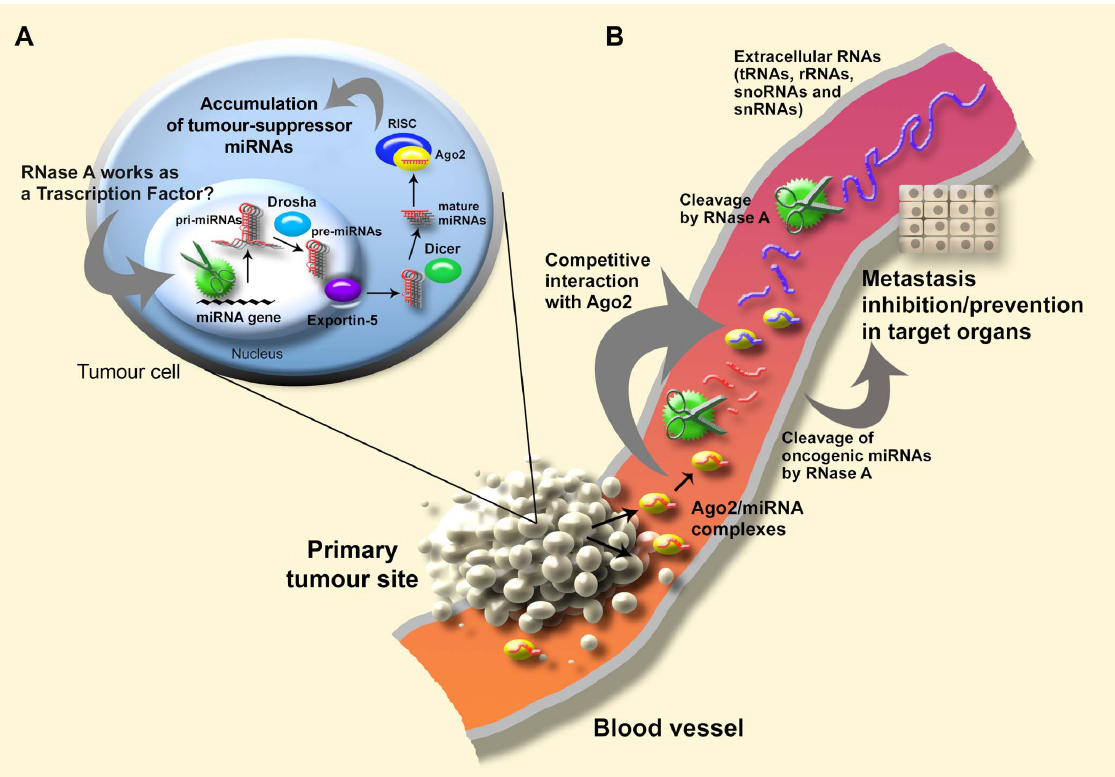
Figure 6. Hypothetical mechanism of the effects of RNase A on the biogenesis of tumour-derived and circulating miRNAs. A . In tumour cells, positively charged RNase A binds with negatively charged tumour tissue (due to the presence of anion phosphatidylserine residues on the surface of tumour blood vessels) and penetrate into the cells. RNase A-mediated increase in miRNA levels in tumour cells may be a result of the activity of RNase A or its proteolytic fragment as a transcription activator. Apparently RNase A displays some properties of homologous angiogenin, which was shown to stimulate ribosomal RNA transcription and protein synthesis [46] and thus can possibly act as a transcriptional activator in tumour cells. B . The primary tumour site is a source of extracellular nucleoprotein complexes, in particular miRNA/Ago2 complexes [37,38]. Recent studies have shown a large number of small ( , 20–30 nt) RNAs, originated from tRNAs, rRNA, snoRNAs and snRNAs, that are able to associate with Ago2 and perform the regulatory role by RNAi pathway [42]. In the bloodstream RNase A, whose concentration in the bloodstream is maintained by daily intramuscular injections, may generate short fragments of extracellular RNAs (tRNAs, rRNAs, snoRNAs, snRNAs), that may competitively displace miRNAs from nucleoprotein complexes, resulting in the degradation of released miRNAs by RNase A. specific for both the tumour and serum are highlighted in light RNA fraction from the tumour tissue of mice with LLC treated purple. miRNAs specific for the serum only are highlighted in with RNase A (RNA STR ). * RPKM (reads per kb per million) =- pink. number of reads of specific miRNA/(size of miRNA(kb) x total number of reads in library(mln)). # Fold change =RPKM_L2/ (DOCX) Table S5 Criteria of miRNA selection. The algorithm for specific for both the tumour and serum are highlighted in light miRNA selection consisted of the following steps: miRNAs of the purple. miRNAs specific for the tumour only are highlighted in L1 library were sorted by abundance score in descending order light blue. and the data of the L2 library were superposed. In a similar way, miRNAs of the L3 library were sorted by abundance score in descending order and the data of the L4 library were superposed. Table S4 Abundance of miRNA in the cDNA libraries The L2/L1 and L3/L4 fold changes were calculated. The top 100 constructed on the base of short RNA fractions from the blood miRNAs of the L1 library with superposed L2 data were selected serum of mice with LLC treated with saline buffer or RNase A. and sorted by L2/L1 fold change in descending order, and then The table shows miRNAs that are significantly changed in the the data of L3/L4 were superposed. At this step, serum-specific blood serum of mice with LLC after treatment with RNase A. L3 – miRNAs that were not discovered in tumour tissue were rejected. cDNA library constructed on the basis of the short RNA fraction Thus, further miRNAs presented in all libraries were analysed. from the blood serum of mice with LLC treated with saline buffer Total score (TS) was calculated as TS= score in L1 + score in L3 (RNA SSc ); L4 – cDNA library constructed on the basis of the short and the data were sorted by total score in descending order. Total RNA fraction from the blood serum of mice with LLC treated fold (TF) was calculated as TF = L2/L1 fold change + L3/L4 fold with RNase A (RNA SSR ). * RPKM (reads per kb per million) =- change and the data were sorted by total fold in descending order. number of reads of specific miRNA/(size of miRNA(kb) x total The ratio between TS and TF (TS/TF) was calculated and the number of reads in library(mln)). # Fold change =RPKM_L3/ data were sorted by TS/TF in ascending order. miRNAs with